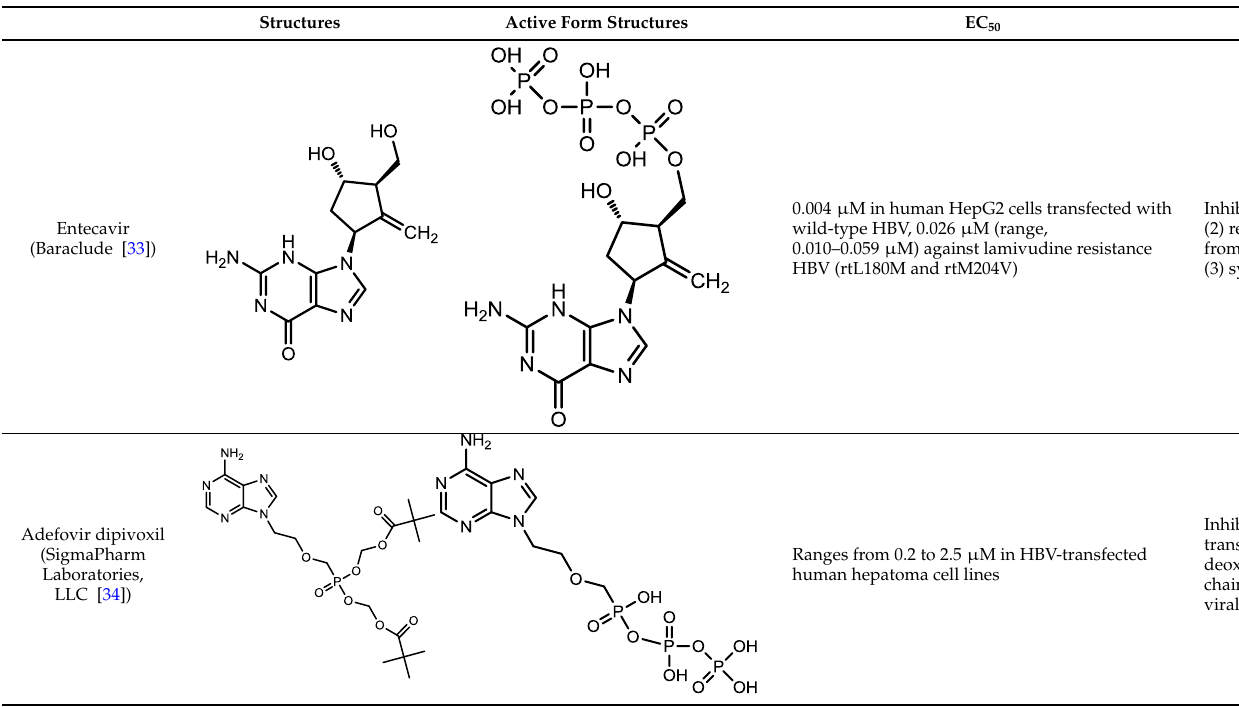
6 Table 1. Summary of the structures of the anti-HBV drugs.